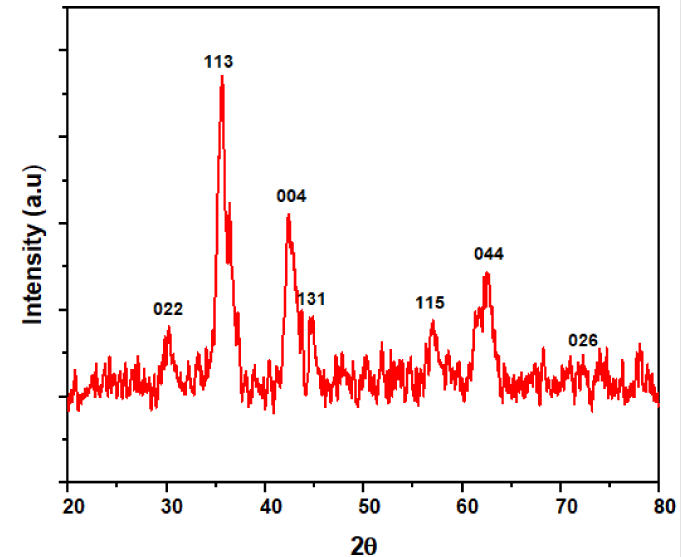
Figure 6. XRD (X-ray diffraction) spectra of the magnetic nanoparticles derived from mill scale waste.